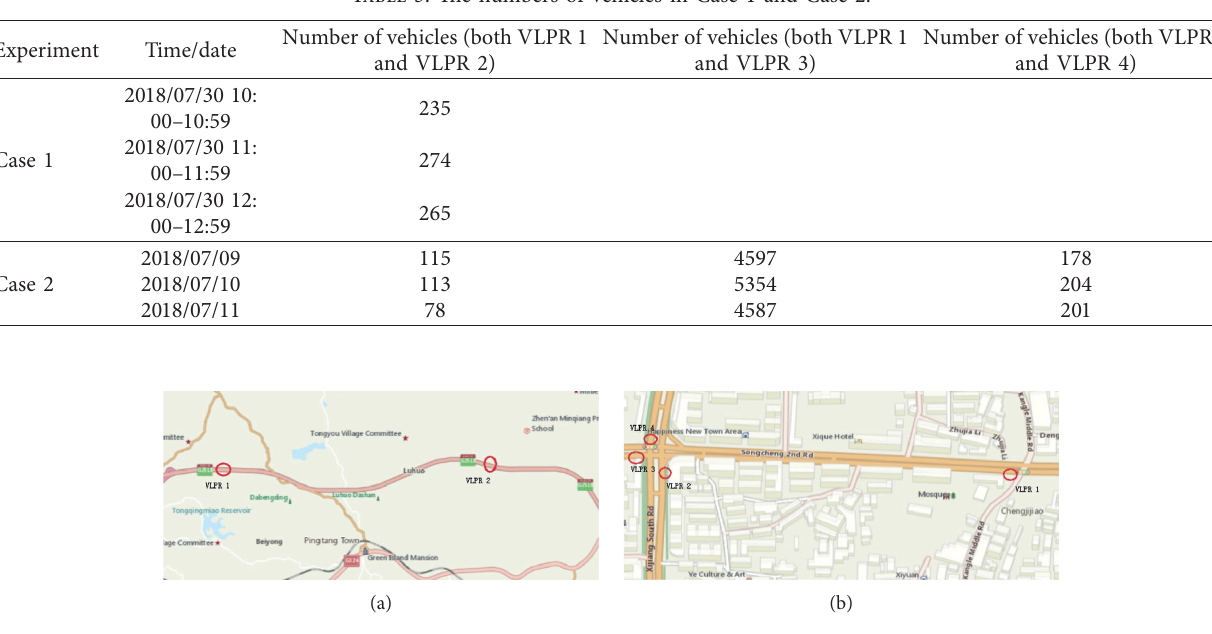
Figure 5: Network geometry. (a) Shenluo highway. (b) Intersection of Songcheng